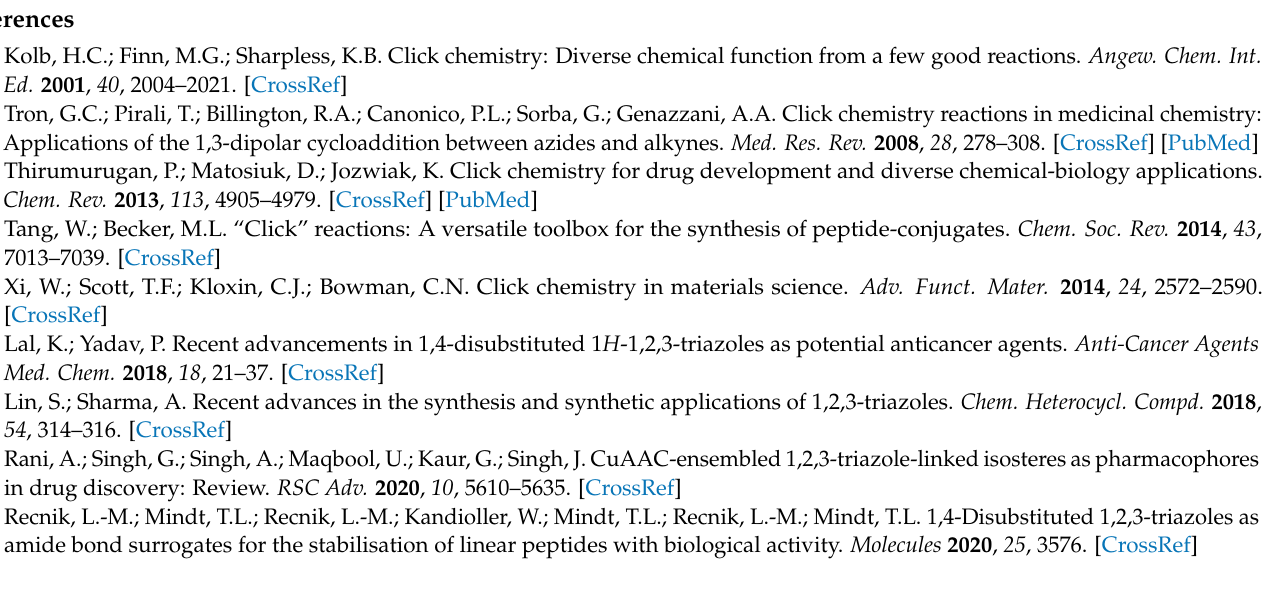
Figure S2: (a) FE-SEM image, elemental mapping of (b) C, (c) N, and (d) Cu, and (e) EDS spectrum of Cu@N-C(400), Figure S3: (a) FE-SEM image, elemental mapping of (b) C, (c) N, and (d) Cu, and (e) EDS spectrum of Cu@N-C(600), Figure S4: (a) FE-SEM image, elemental mapping of (b) C, (c) N, and (d) Cu, and (e) EDS spectrum of Cu@N-C(800), Figure S5: Powder XRD pattern of (a) fresh and (b) used Cu@N-C(600), Figure S6: (a) FE-SEM image, elemental mapping of (b) C, (c) N, and (d) Cu, and (e) EDS spectrum of the used Cu@N-C(600) (the first run), Figure S7: (a) FE-SEM image, elemental mapping of (b) C, (c) N, and (d) Cu, and (e) EDS spectrum of the used Cu@N-C(600) (the second run), Figure S8: (a) FE-SEM image, elemental mapping of (b) C, (c) N, and (d) Cu, and (e) EDS spectrum of the used Cu@N-C(600) (the fourth run); characterization data of compound 4a – 5b , Table S1: Comparison of catalytic performance between Cu@N-C(600) and other types of catalysts. References [48–60] are cited in the supplementary